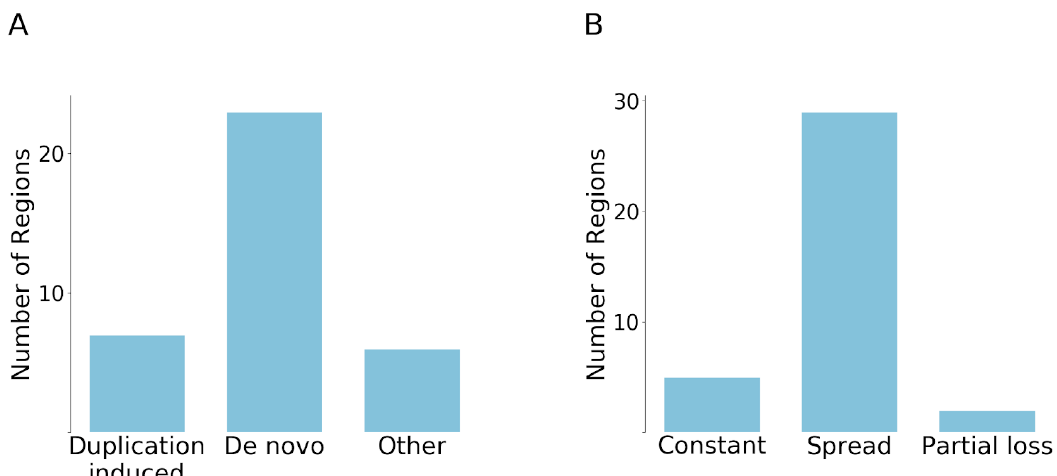
Figure 4. Categorization of emergence scenarios and evolutionary fates of cancer regions. ( A ) The number of regions that have emerged by duplication or de novo. Six regions were not categorized (Other). ( B ) Classification of cancer regions in terms of their evolutionary fate after emergence.